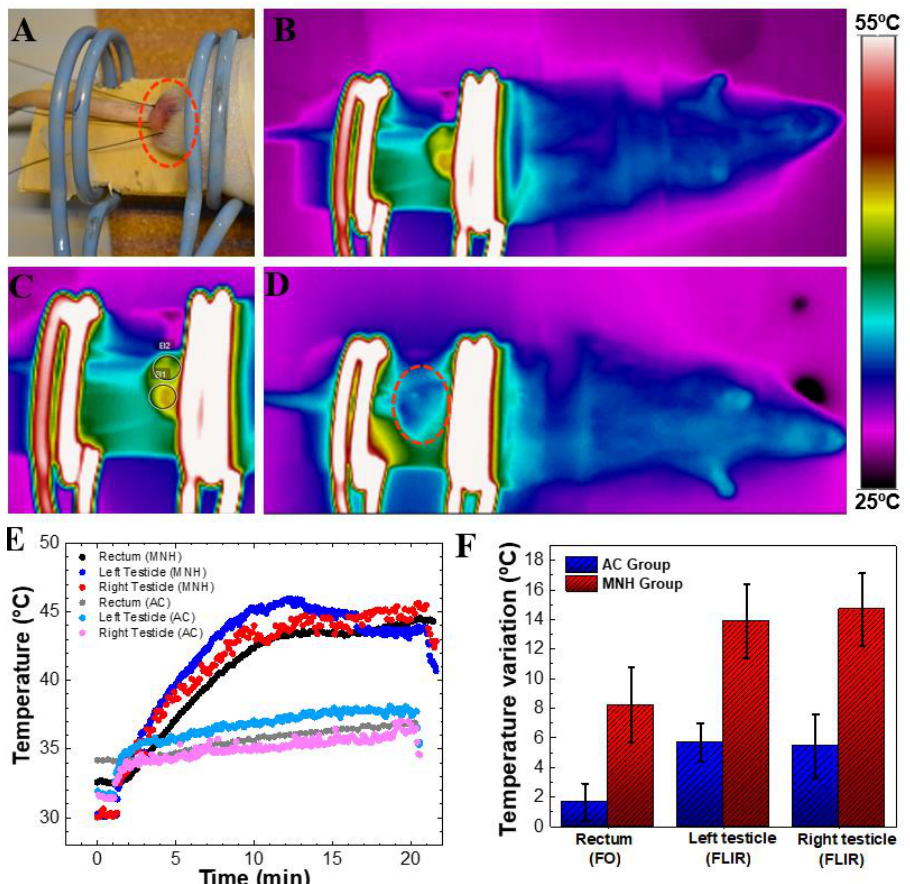
Figure 3. ( A ) Positioning of the animal’s testicles on the magnetic field coil. Note: fiber-optic probes to measure testicular and rectal temperatures. ( B ) Thermographic image of an animal during the procedure of magnetic nanoparticle hyperthermia when the average temperature of the testicles was 45 ◦ C. It is possible to visualize that the only heated part of the body is the testicular area. ( C ) Photograph of the testicular region of the same ( B ) MNH group animal. ( D ) Thermographic image of an AC group animal after 15 min of magnetic field exposure. Note that no heat generation was observed in the testicular region. ( E ) Temperature data of both animals, MNH group and AC group, during treatment. Rectal temperature was obtained using a fiber-optic thermometer, while the left and right testicle temperatures correspond to an average value obtained using the thermal camera. ( F ) Temperature increase in AC and MNH groups considering all animals investigated (mean ±